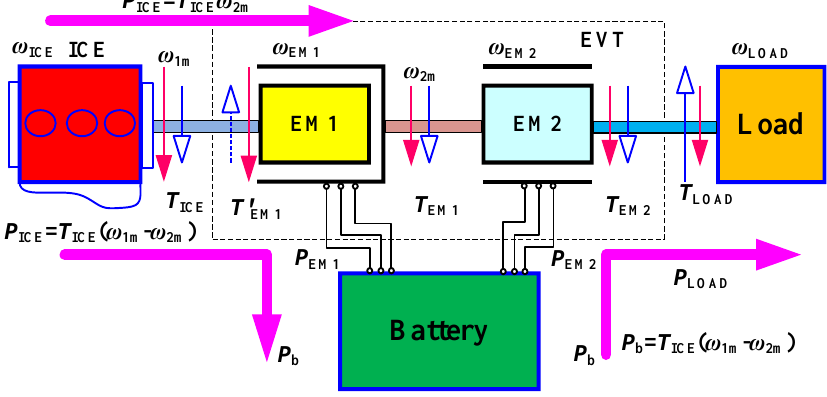
Figure 4. The diagram of the energy flows in the HEV based on the CSPM motor. EVT, electric variable transmission.